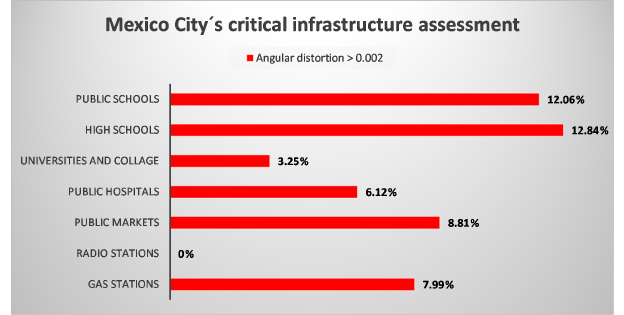
Figure 5. Mexico City’s critical infrastructure